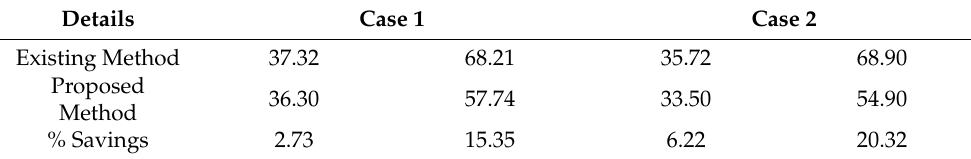
Table 4. % Savings in tolerance cost and machining